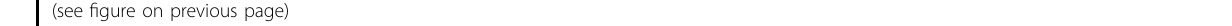
Fig. 4 Subtype-speci fi c differential gene expression and gene set overrepresentation analyses depicting common gene expression changes amongst different types of immune cells after vaccination. a 11 major immune cell-type-speci fi c DEGs identi fi ed by pseudo-bulk data produced by combinations of samples before and after vaccination. Genes with logFC > 0.5 and adjust P < 0.05 were included. b Overrepresentation analysis of HALLMARK gene sets from MSigDB amongst 11 major cell types demonstrated common changes in gene sets representing altered immunological states before and after vaccination. c , d UMAP visualization colored by average expression scores (levels) based on differential enrichment pathway. Box plot depicting the expression score distribution before and after